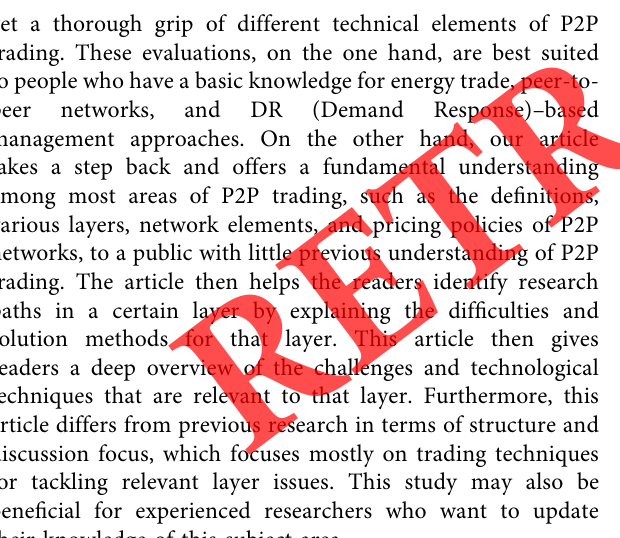
FIGURE 1 | A demonstration of the virtual layer and physical layer platform for P2P energy